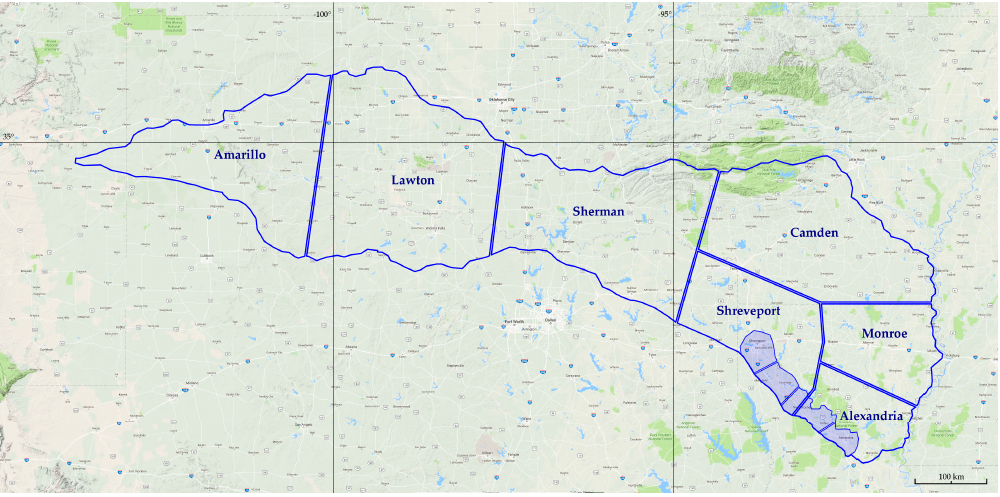
Figure 1. The distinguished regions of the Red River basin.